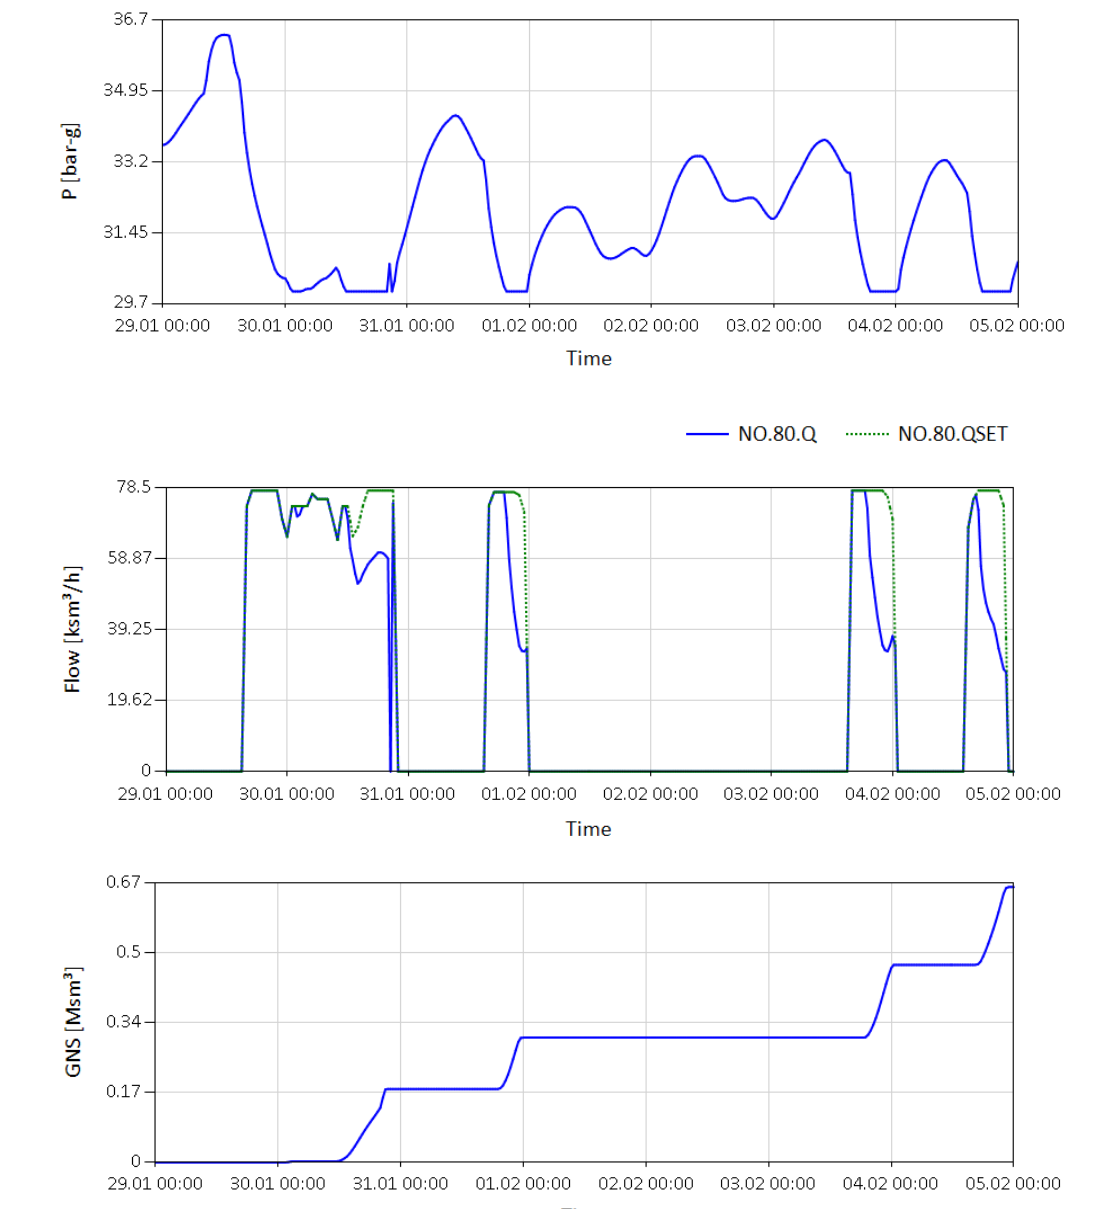
Figure 10. Time evolution of pressure, scheduled offtake, actual offtake, and cumulative gas not supplied for fuel offtake node NO.80 of gas generator gen36 for DA simulation for Q1 and for a 20% wind and solar